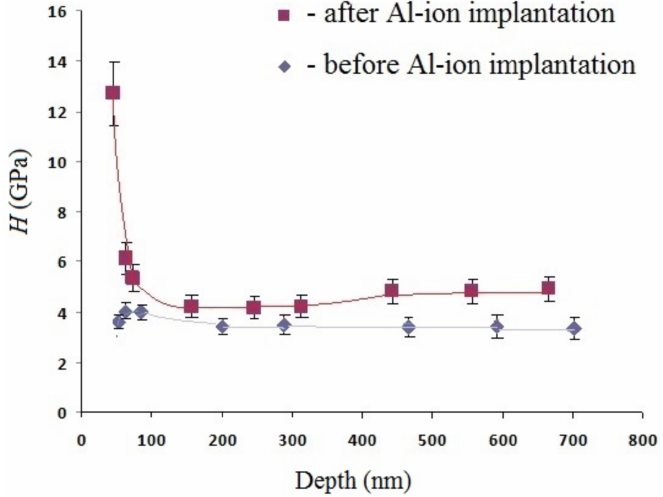
Figure 2. Dependence of nanohardness on the penetration depth of indenter before and after irradiation with aluminum